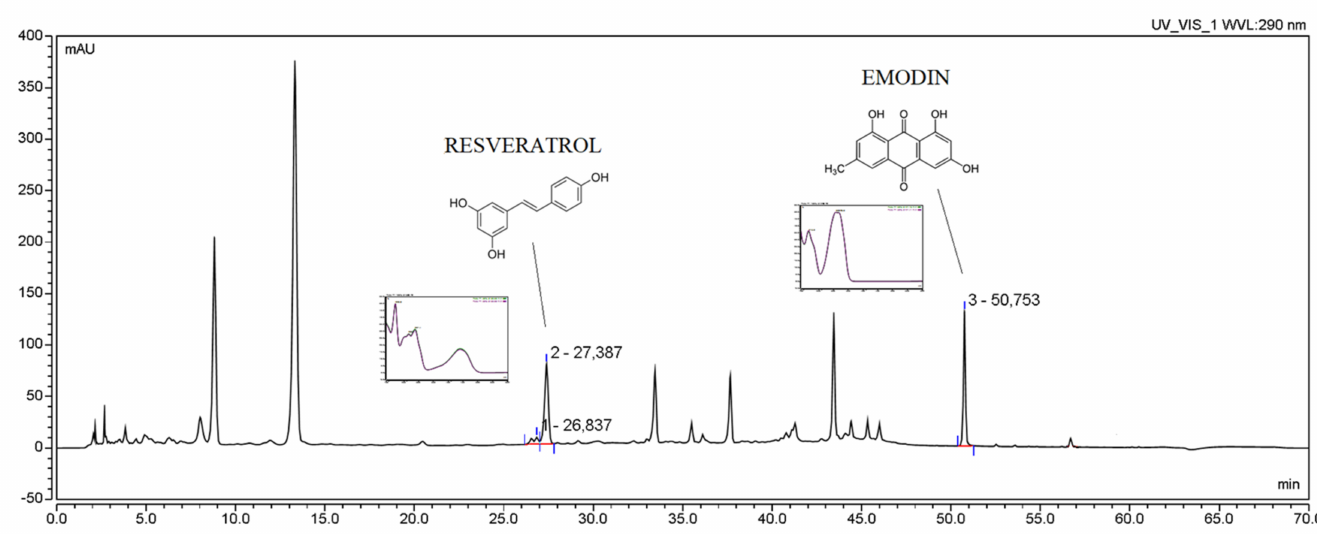
Figure 1. The HPLC chromatogram of Polygoni cuspidati rhizome and root extract L5 (concentration 5 mg/mL) with selected patterns of resveratrol and